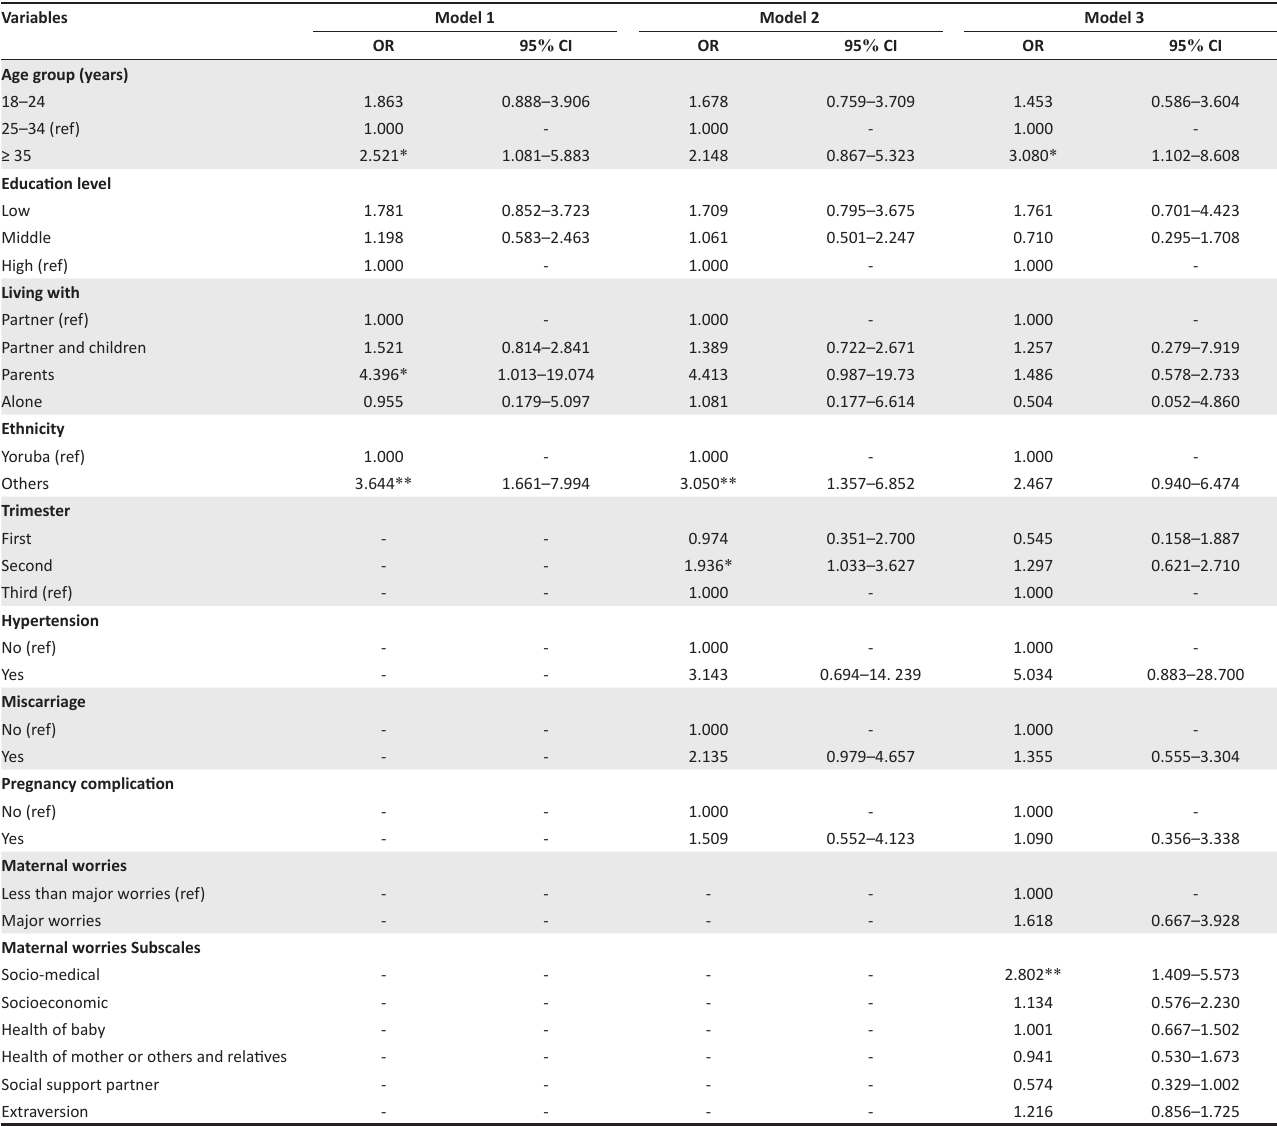
TABLE 5: Hierarchical logistic regression analysis of predictors of pregnancy-related anxiety symptoms amongst